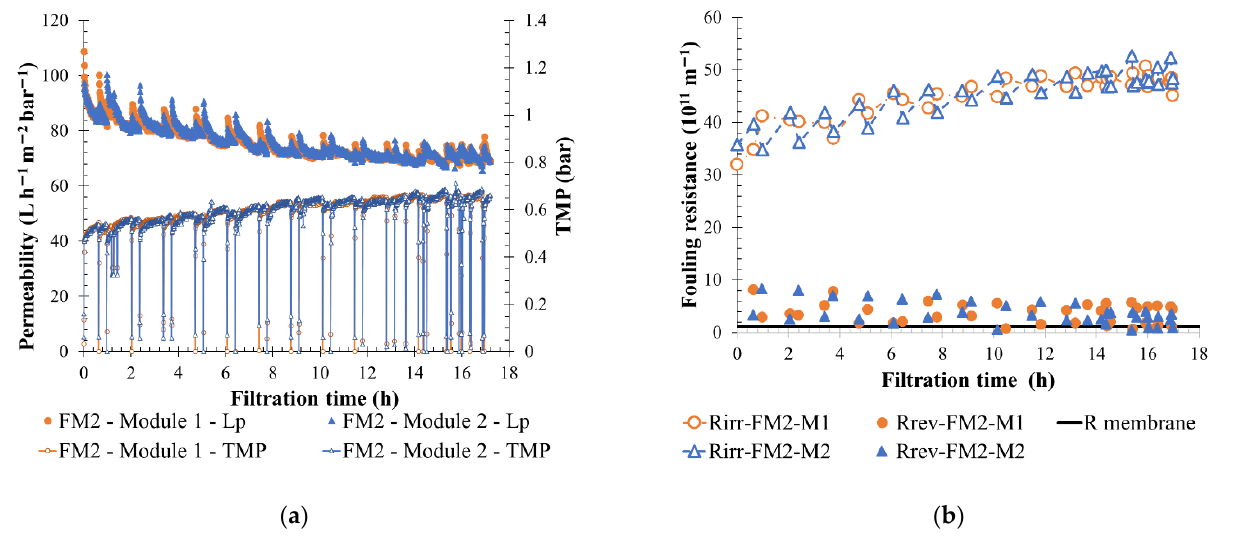
Figure 16. Variation of permeability at 20 °C and TMP ( a ), fouling resistance ( b ) throughout the filtration time with BW initiate every 20 min on the entire membrane filtration unit − 1/80 min on one filtration module, a permeate flux of 63 L h −1 m −2 .T = 20 °C, feedwater from CC -LOUIS BLERIOT process tank 2 after pre-treatment steps; 1 line of 2 module k99 in parallel SiC membrane 32.67 m 2 /module. FMx is the line considered, Mx is the membrane, Lp is the permeability value, TMP the transmembrane pressure and Rw is the total recovery rate applied on the unit; R irr is irreversible resistance; R rev is reversible resistance and R membrane is the membrane resistance.